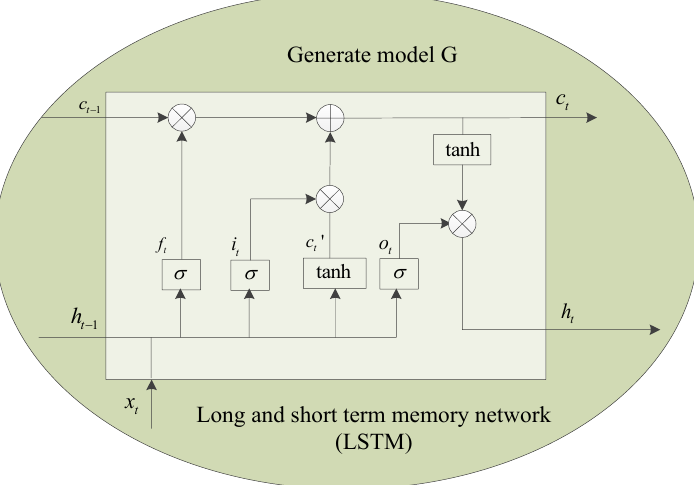
Figure 5. LSTM network structure.